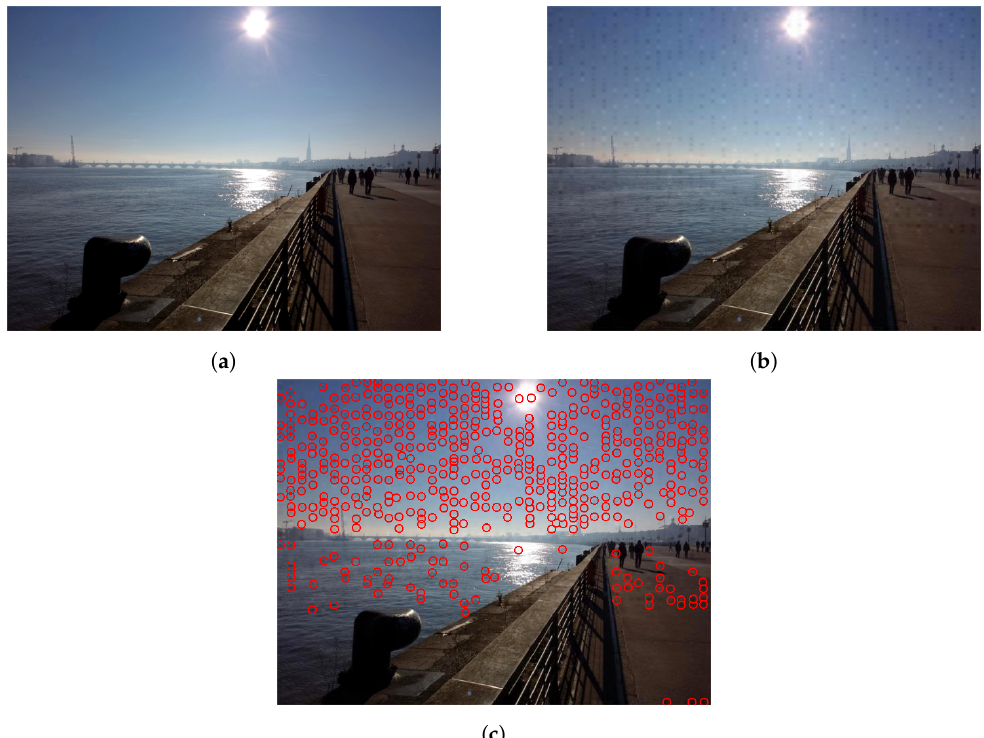
Figure 3. The original image ( a ), the SilentEye outcome ( b ), and the same SilentEye outcome with red circles highlighting artefacts, particularly evident in the sky ( c